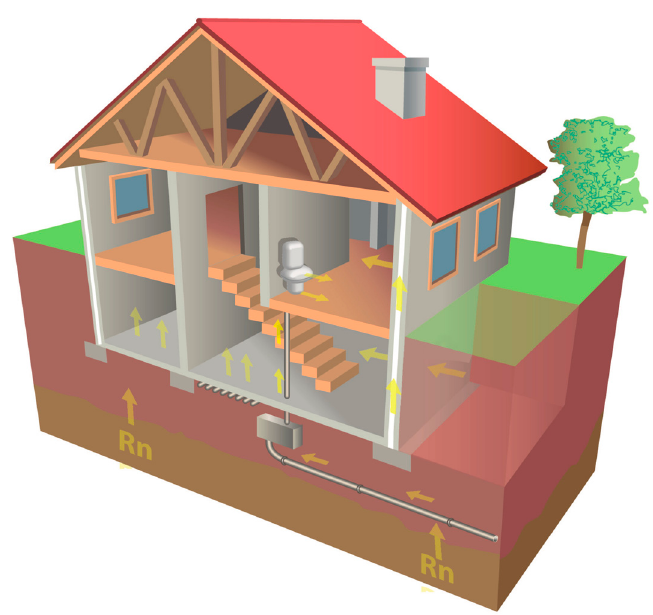
Figure 2. Radon accesses to a home: access through cracks in the subsoil, accumulation in lower floors and/or basements due to poor ventilation, through water pipes that are contaminated in the subsoil and transfer radon to higher levels, where it is filtered through taps, toilets and/or showers.